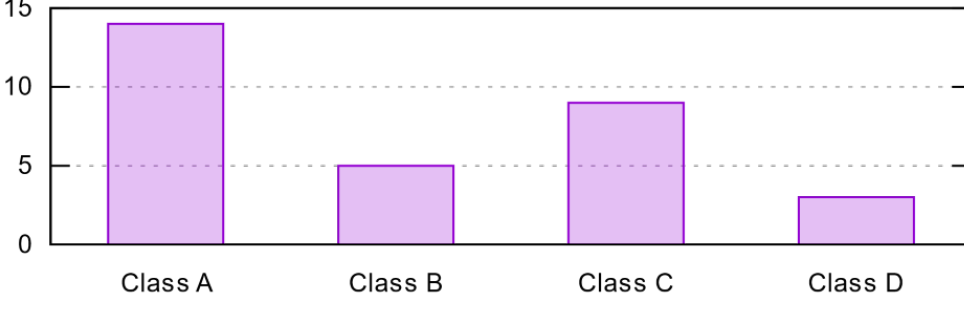
Figure 6. A breakdown of modeling approaches into classes described for the reviewed